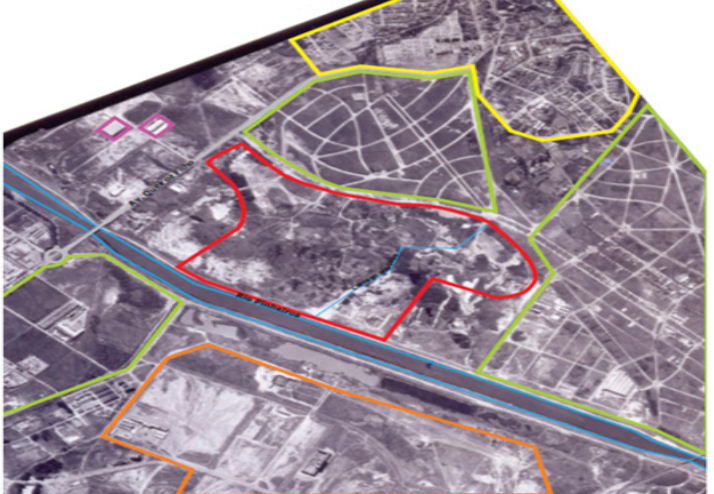
Figure 4. Villa-Lobos site. Occupation of the area and neighborhood in 1958. Colors: Red: Villa-Lobos Park Area; Brown: Earth movement; Green: green area/allotment; Blue: Body of water; Yellow: residences; Purple: industries; Orange: University of São Paulo [19].